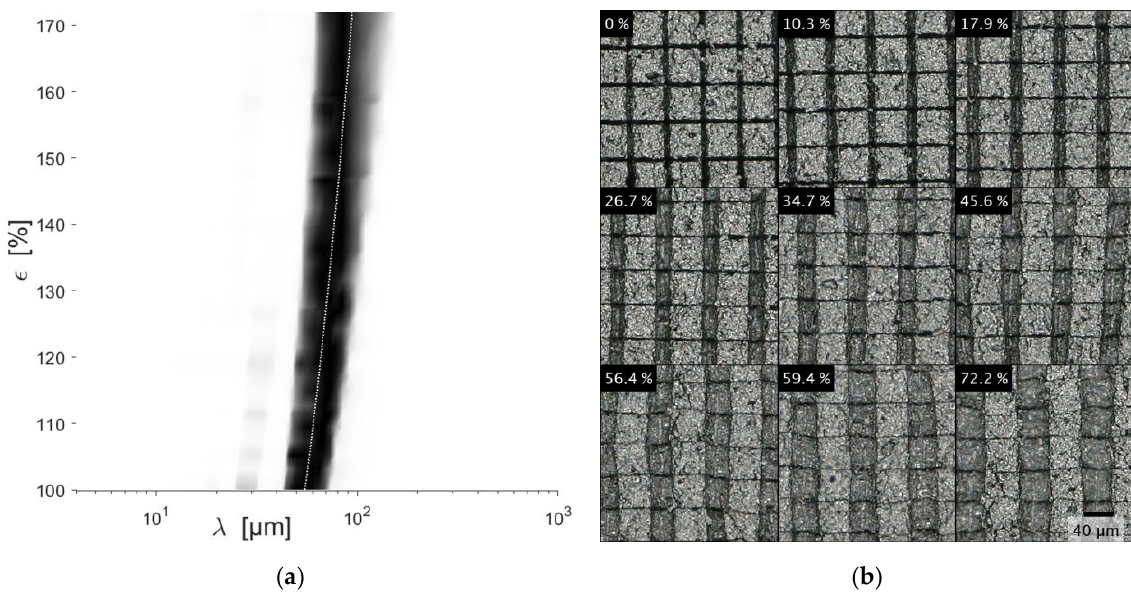
Figure 6. Microscope images (real space) of strained DLC coating with structure 1 ( b ) and the corresponding SPD ( a ). The dotted white line highlights the measured strain. The SPD is normalized, and the contrast is enhanced by taking the fourth power.